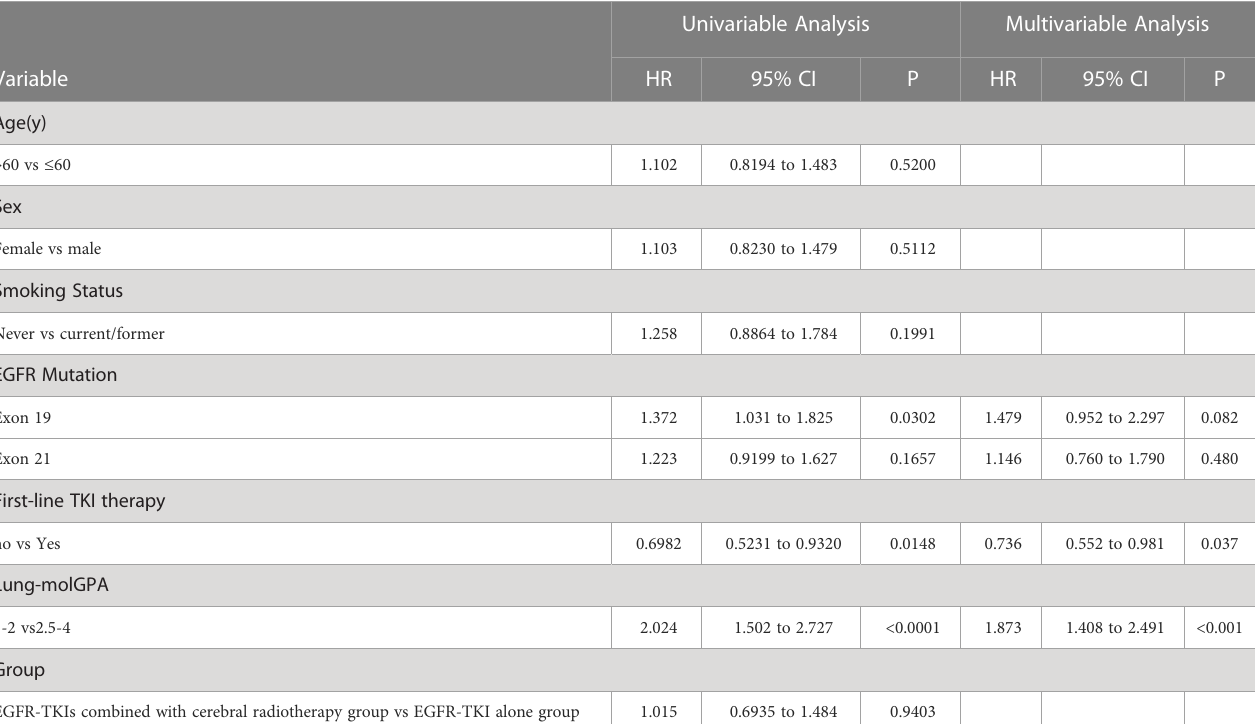
TABLE 4 Univariable and multivariable analyses of covariables associated with